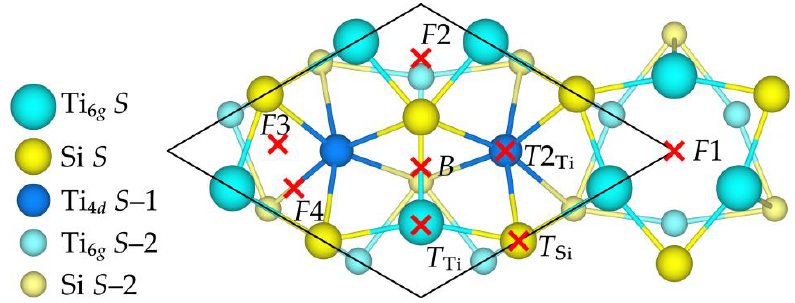
Figure 4. Positions of oxygen adsorption on the Ti 5 Si 3 (0001) TiSi surface.